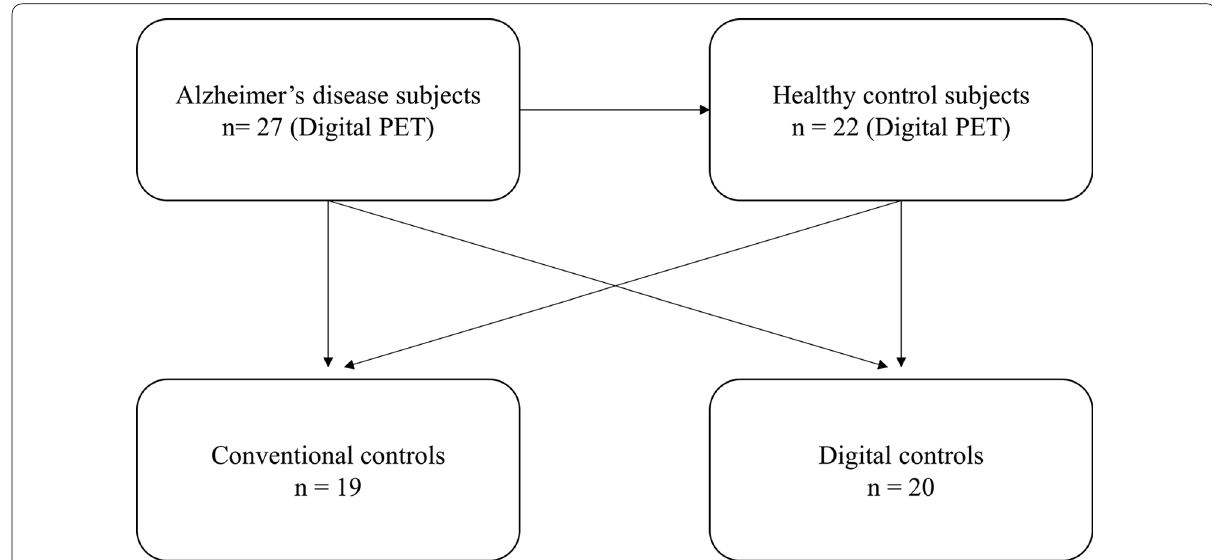
Fig. 1 Flowchart for the constitution of the two different groups of Alzheimer’s disease and healthy control subjects, and the conventional and digital control databases. Black arrows are representative of analyses